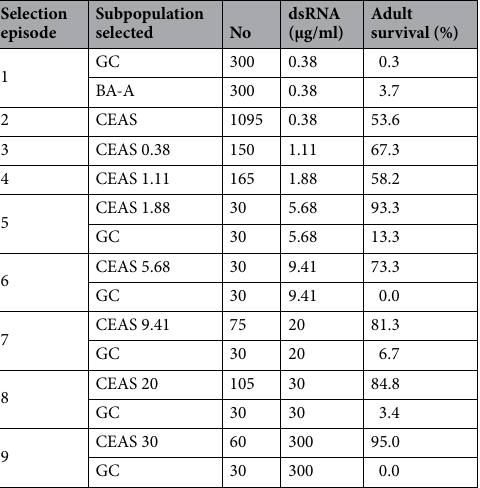
Table 1. Summary of steps and observations in selection of resistance to dsRNA targeting the V-ATPase subunit A gene in Leptinotarsa decemlineata. In each selection episode, a solution of dsRNA at the concentration stated was used to coat potato leaves, which were fed to L. decemlineata from second instar until prepupae. GC = general colony containing collections of L. decemlineata from locations detailed in Fig. 1, BA-A = colony of survivors from preliminary bioassays, CEAS = Chronic Exposure Adult Surviving (specific dsRNA dose to which the adults survived is stated in each selection step). No. = Number of larvae used in each episode of selection (for CEAS) or to determine control susceptibility to a dsRNA treatment (for GC).